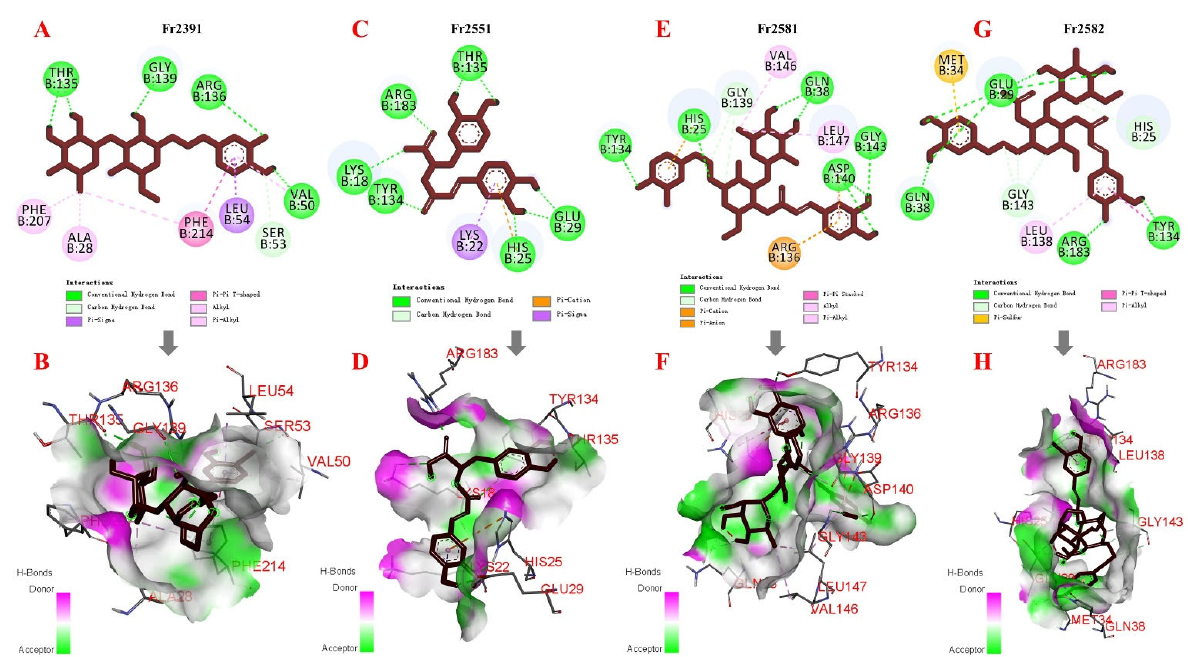
Figure 9. Molecular docking analysis of HO-1 (PDB ID: 1N3U) during binding to Fr2391, Fr2551, Fr2581, and Fr2582. ( A , C , E , G , respectively) indicates the 2D interaction diagrams, with ( B , D , F , H ) showing binding models of HO-1’s interactions with Fr2391, Fr2551, Fr2581, and Fr2582, respectively.